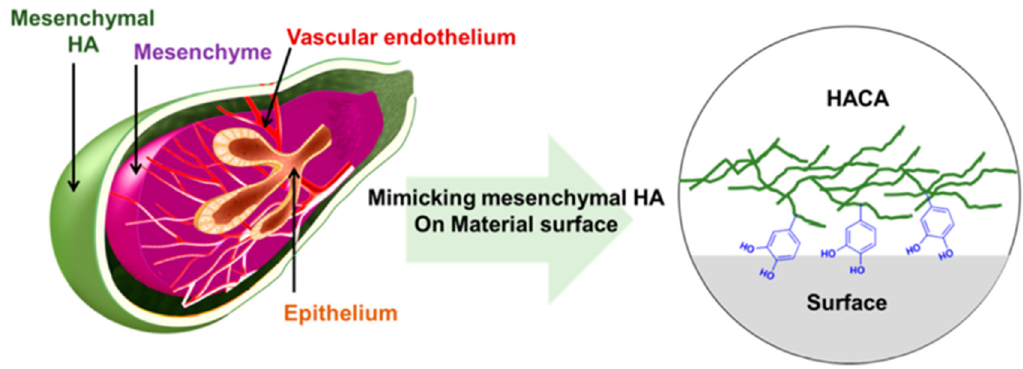
Figure 7. Schematic illustration of mesenchymal HA-mimicking HA–catechol platform for salivary gland tissue engineering. Reprinted with permission from [44]. Copyright © 2020 American Chemical